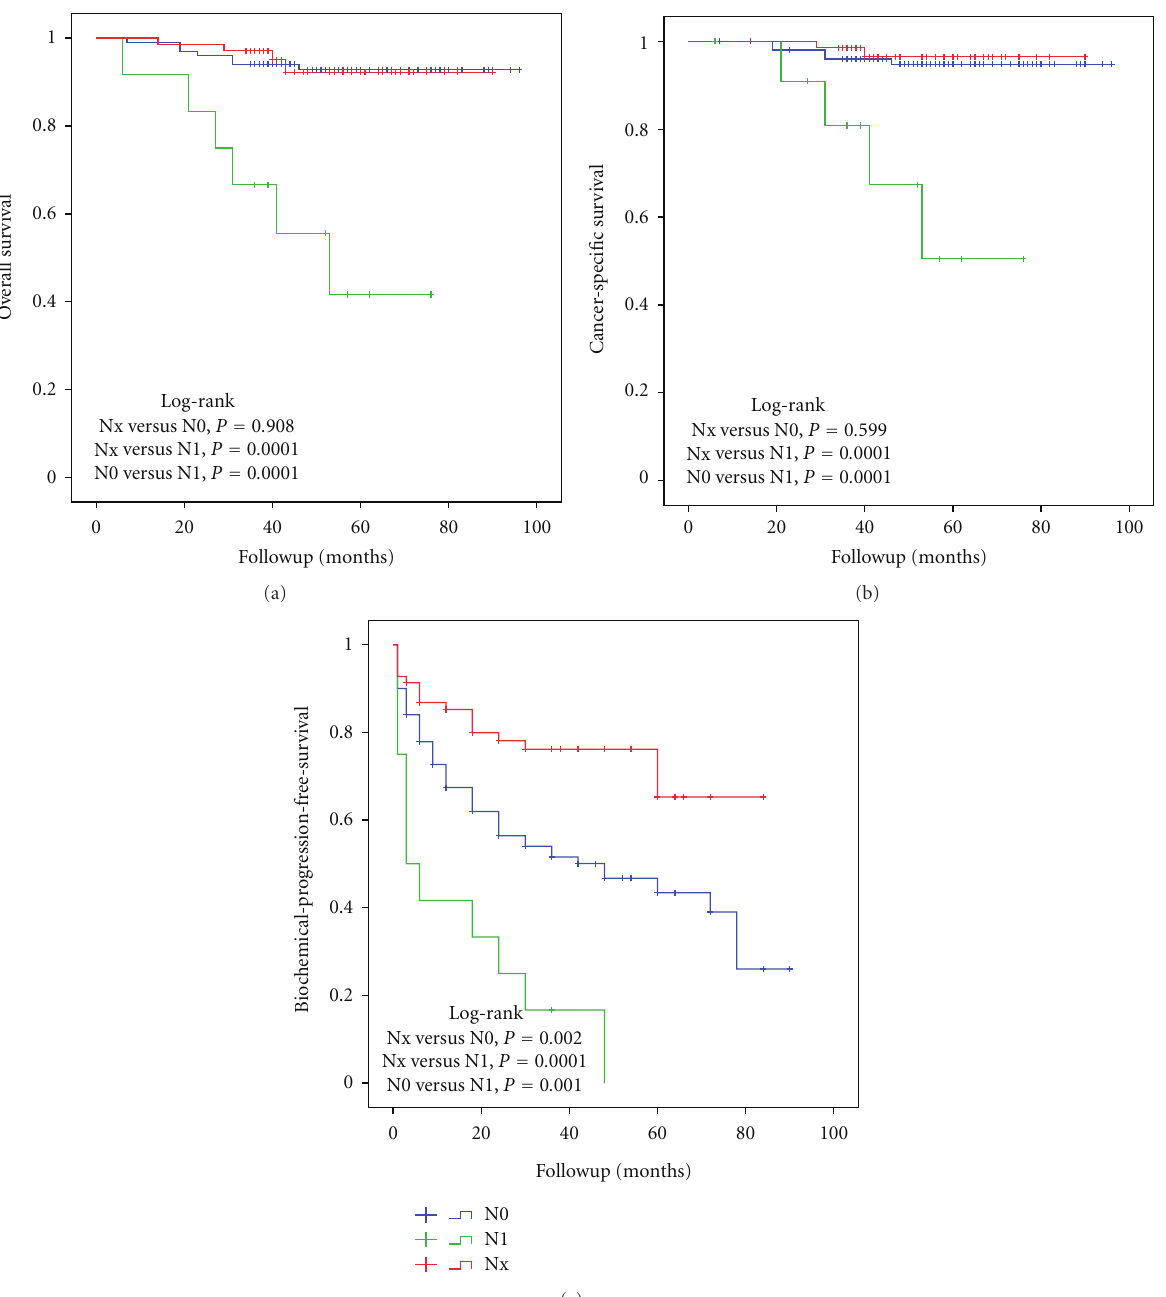
Figure 1: The Kaplan-Meier analysis with log-rank test for overall (a), cancer-specific survival (b), and biochemical-progression-free survival (c) stratified for lymph node